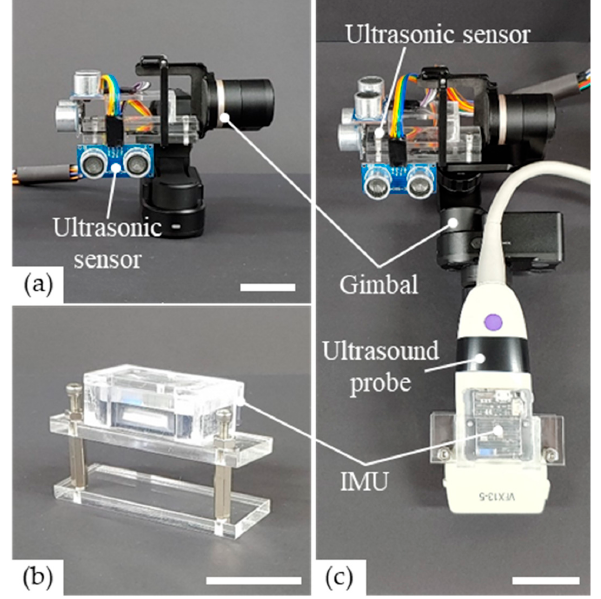
Figure 1. Photographs of the proposed low-cost devices attached to the commercial ultrasound probe. ( a ) Three ultrasonic sensors are placed perpendicularly to each other and are combined with a gimbal to acquire the position data of the probe. ( b ) The inertial measurement unit (IMU) and the poly(methyl methacrylate) (PMMA) housing were combined easily with the probe to obtain orientation data of the commercial ultrasound probe. ( c ) Overall, the proposed low-cost devices are attached to a probe for the acquisition of volumetric ultrasound images. All scale bars are 35 mm.